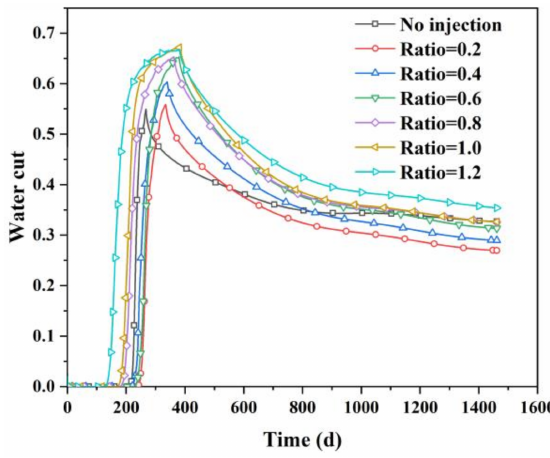
Figure 8. Water cut of parent